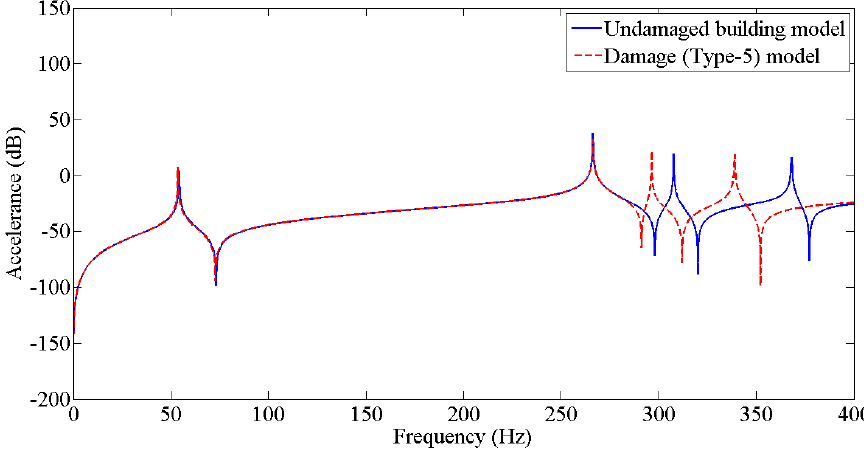
Figure 10. Prediction of structural dynamic behavior of building model under undamaged and damaged (Type − 5) conditions through FRFs.